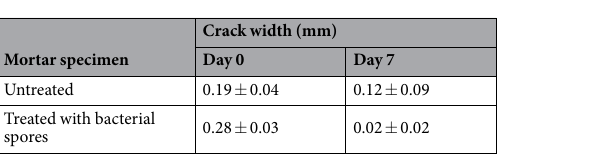
Mortar specimen